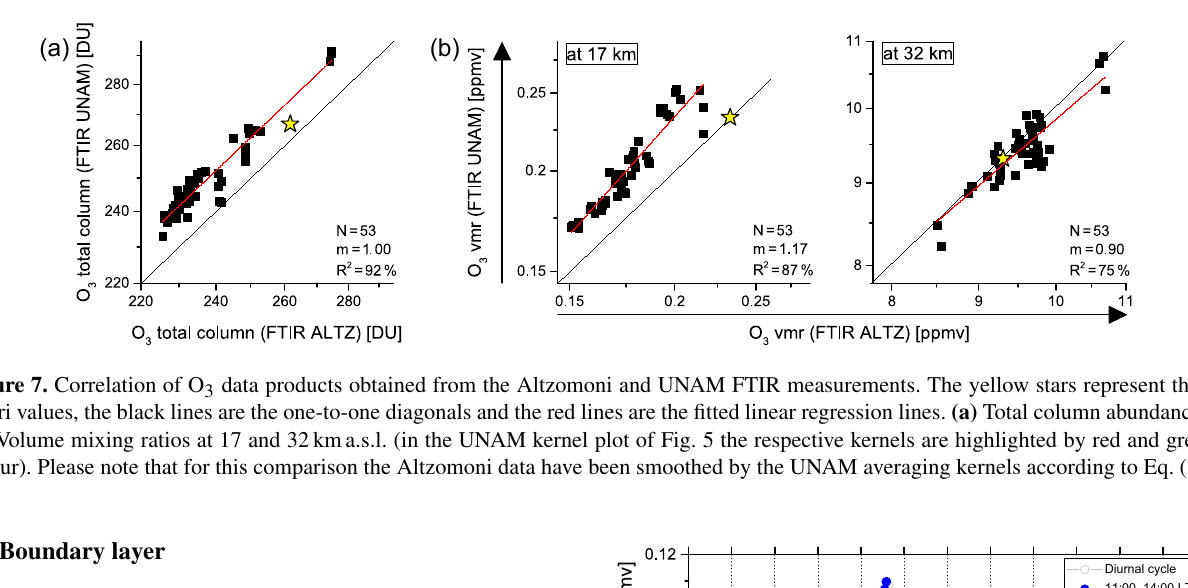
4 Boundary layer